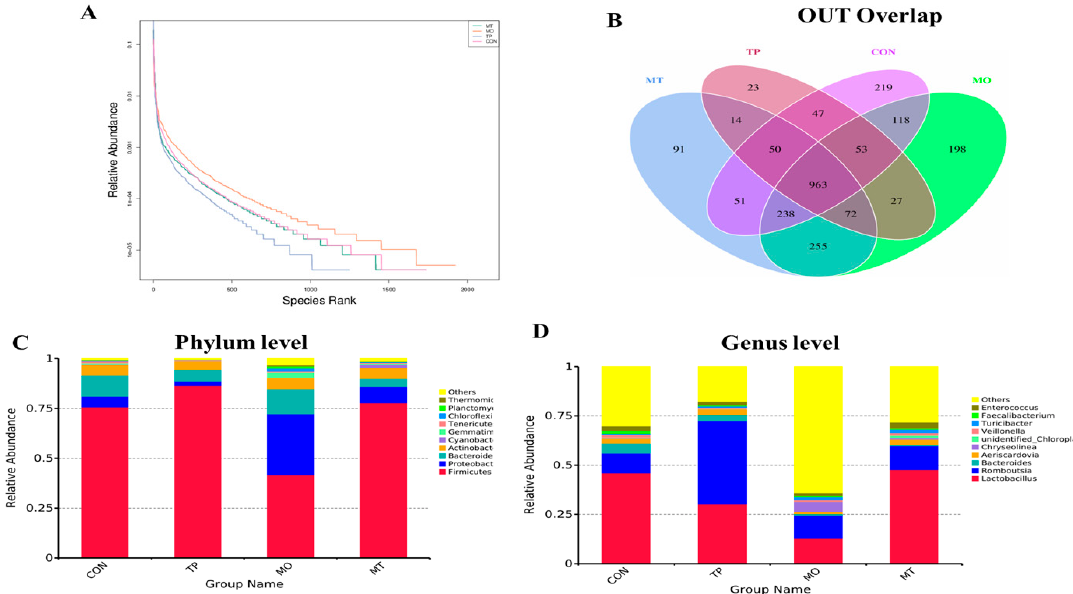
Figure 2. Rank abundance curve of bacterial OTUs derived from each sample ( A ). Venn diagram illustrated in cecum microbiota among the samples ( B ). The relative abundance of the top 10 phylum from samples ( C ). Bar graph of the top 10 genus from samples ( D ). Table 2. Effect of molybdenum and tea polyphenols on top 5 phylum abundance of cecum microbiota of laying hens.